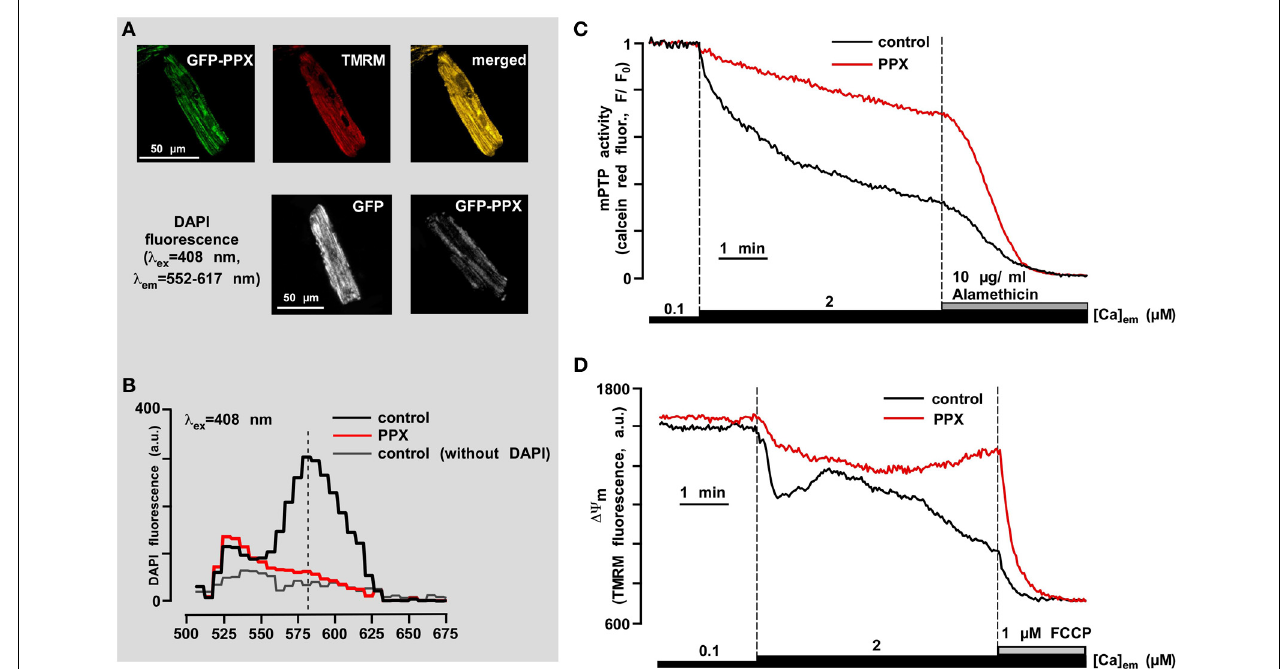
FIGURE 6 | PolyP depletion prevents opening of the permeability transition pore induced by mitochondrial Ca 2 + overload. (A) The upper panel shows co-localization of GFP-PPX signal with mitochondria. TMRM was used as a mitochondrial signal and the degree of overlay is presented in shades of yellow in the merged image. The bottom panel shows the decrease in DAPI fluorescence in polyP-depleted cells. (B) Fluorescence spectrum of DAPI (5 μ M) loaded myocytes expressing control GFP (black), PPX (red), and control GFP cells not loaded with DAPI (gray). (C) Original recordings of mPTP opening using calcein red release from mitochondria of